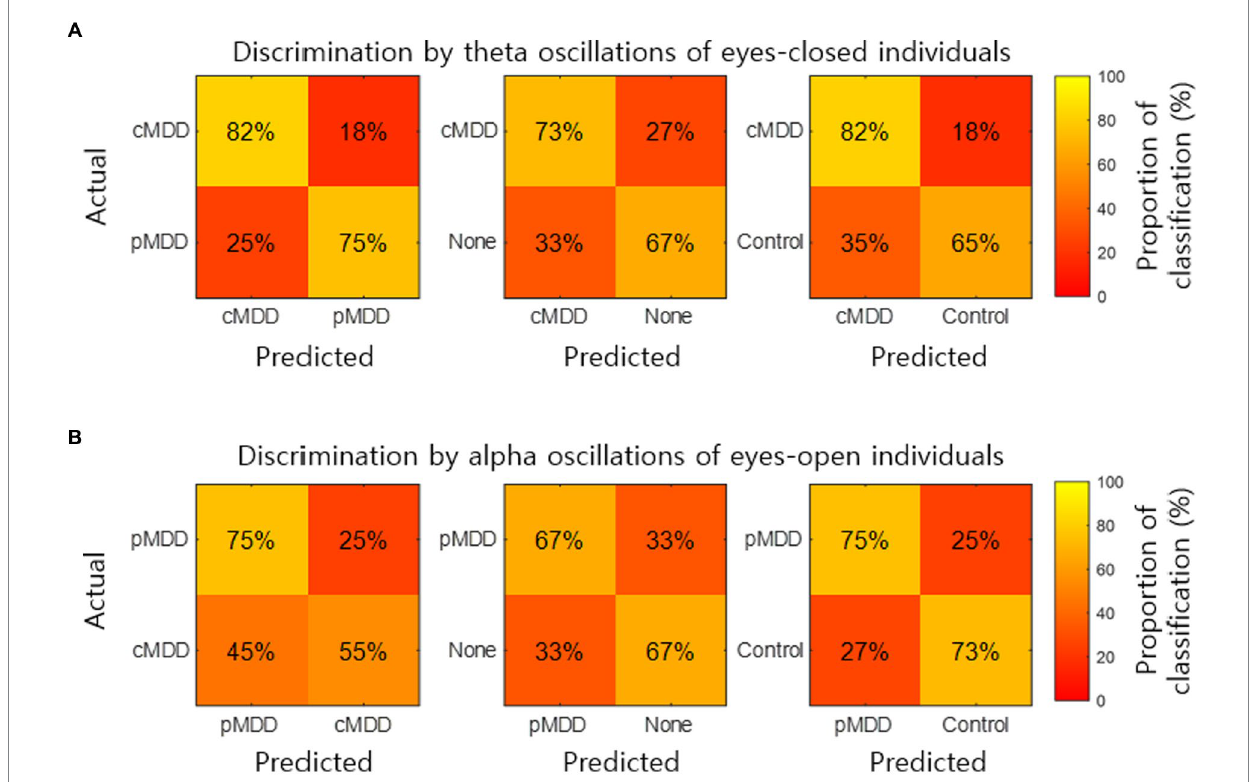
FIGURE 9 Discrimination of individuals by two kinds of biomarkers. (A) The normalized confusion matrix for the 2-classes discrimination (cMDD vs. pMDD, cMDD vs. None, and cMDD vs. Control) using spatial correlations ( M ψ in Eq. 2). (B) The normalized confusion matrix for the 2-classes discrimination (pMDD vs. cMDD, pMDD vs. None, and pMDD vs. Control) using spatial correlations ( M ψ in Eq. 2).